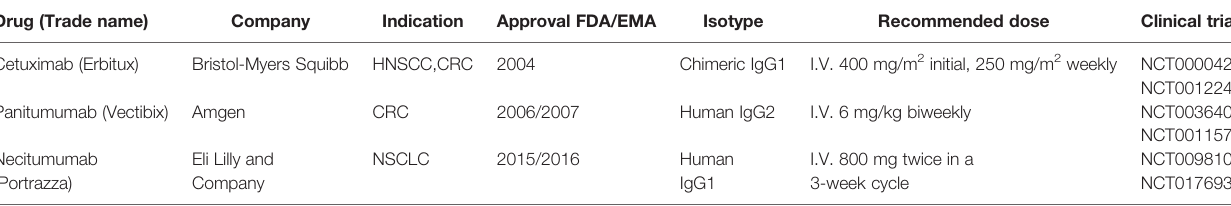
TABLE 1 | Summary of approved EGFR-targeted